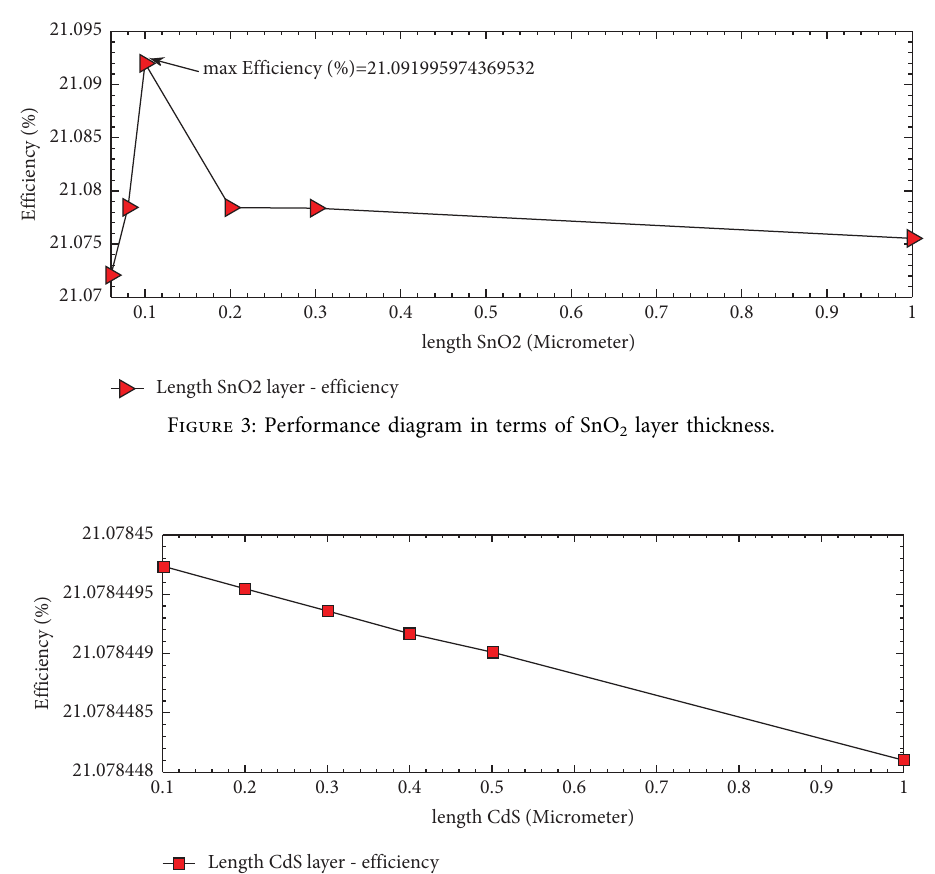
Figure 4: Performance chart in terms of CdS layer thickness. Table 2: Te thickness of the layers in Figures 5–7.